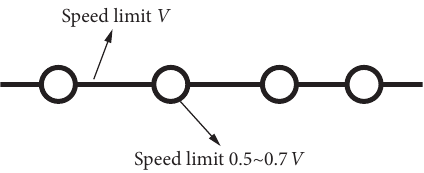
Figure 4: The speed limit at intersections and adjacent road segments in China.